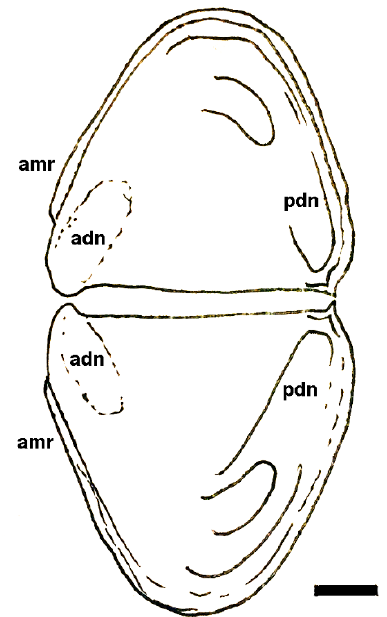
Figure 5. Beyrichona avanga . Paired shields shown in butterfly position. Anterior to left. Scale bar 200 microns. Abbreviations: adn , anterodorsal node; amr , admarginal rim; pdn , posterodorsal node. Image Credit: Mark McMenamin.